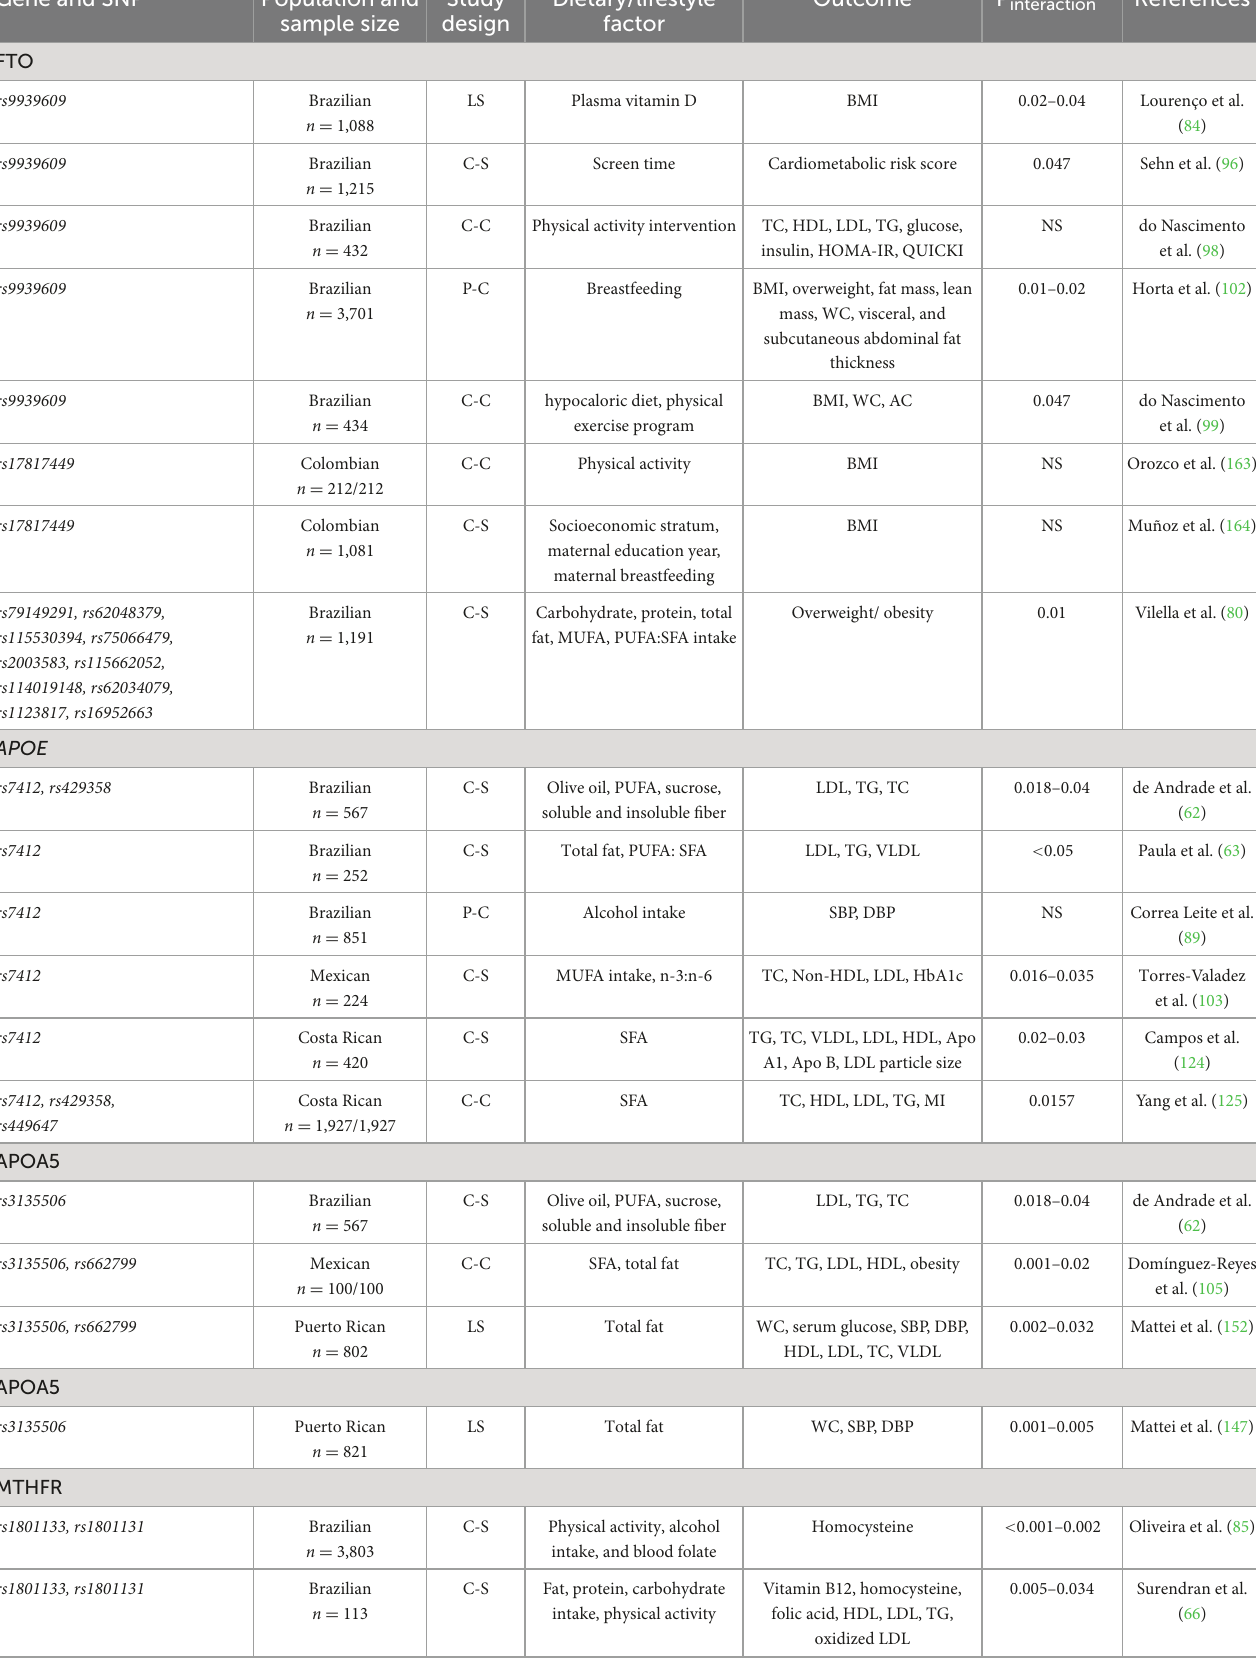
TABLE 1 Summary table of gene-lifestyle interactions and study